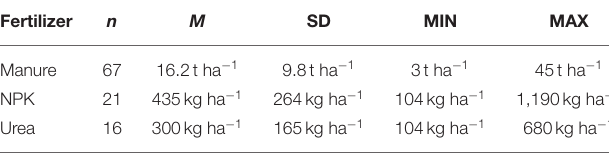
TABLE 5 | Elemental concentrations of tubers and